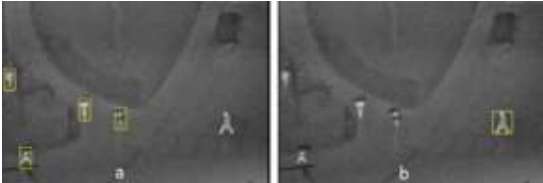
Figure 13. ROIs with possibility of presence of one pedestrian (a) and possibility of presence of several pedestrians (b).